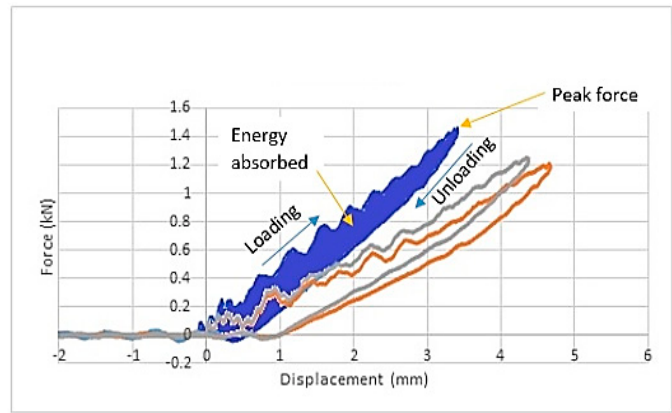
Figure 1. Force-displacement graphs of EP at the 2.5 J impact energy level showing closed curves.